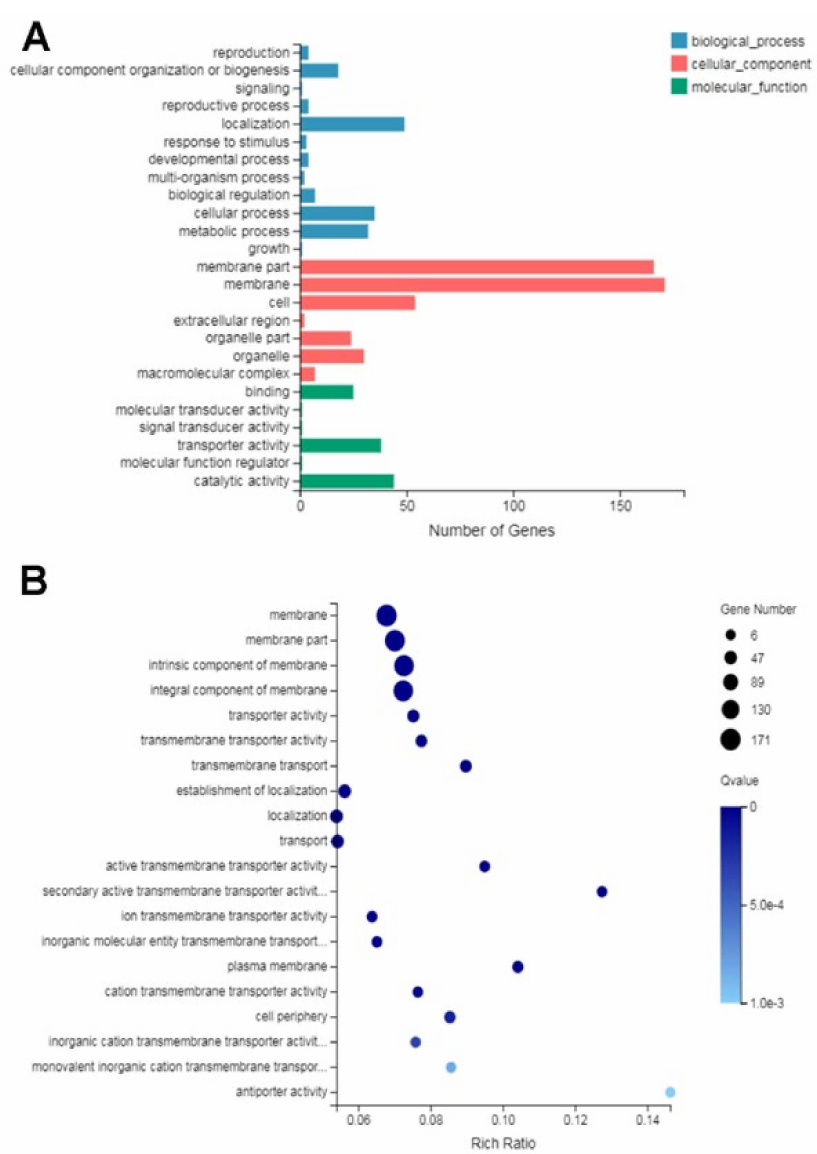
Figure 5. GO analysis of DEGs. ( A ) GO classification of DEGs. ( B ) GO annotation of DEGs related to membrane and membrane